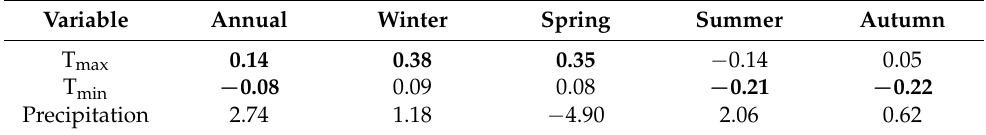
Table 4. Sen’s estimator for annual and seasonal T max , T min ( ◦ C/decade) and precipitation (mm/decade) during 1955–2016 in the UIB. Bold indicates significant trend at 5%